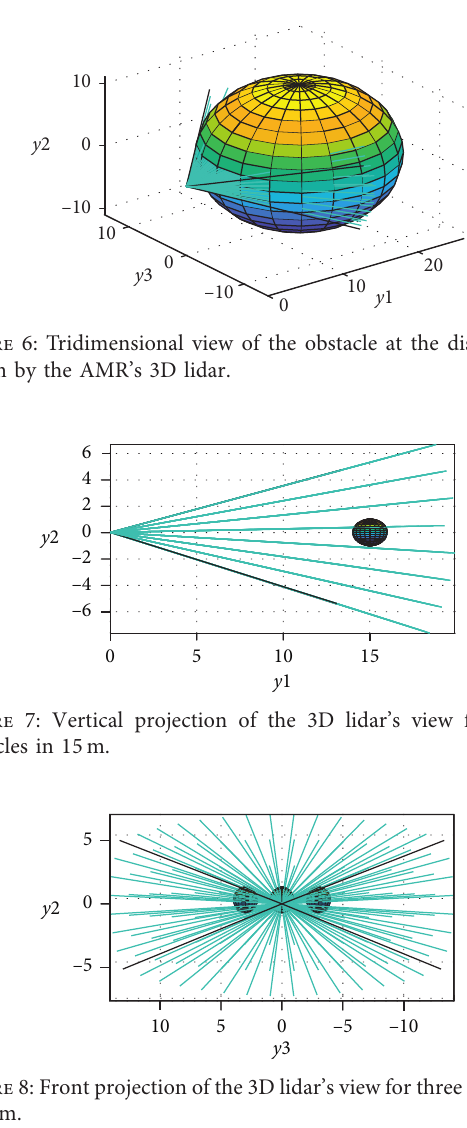
Figure 2: Vertical projection of the 3D lidar’s view for one obstacle in 15 m.